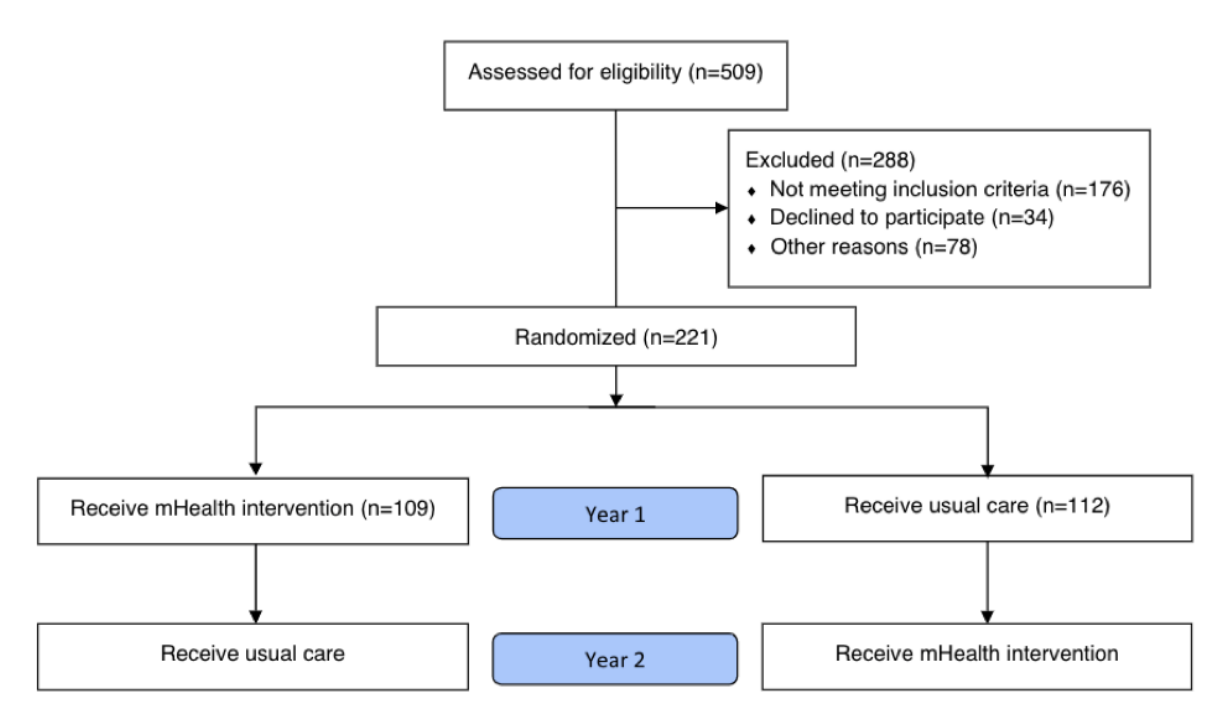
Figure 2. Consolidated Standards of Reporting Trials flow diagram. mHealth: mobile